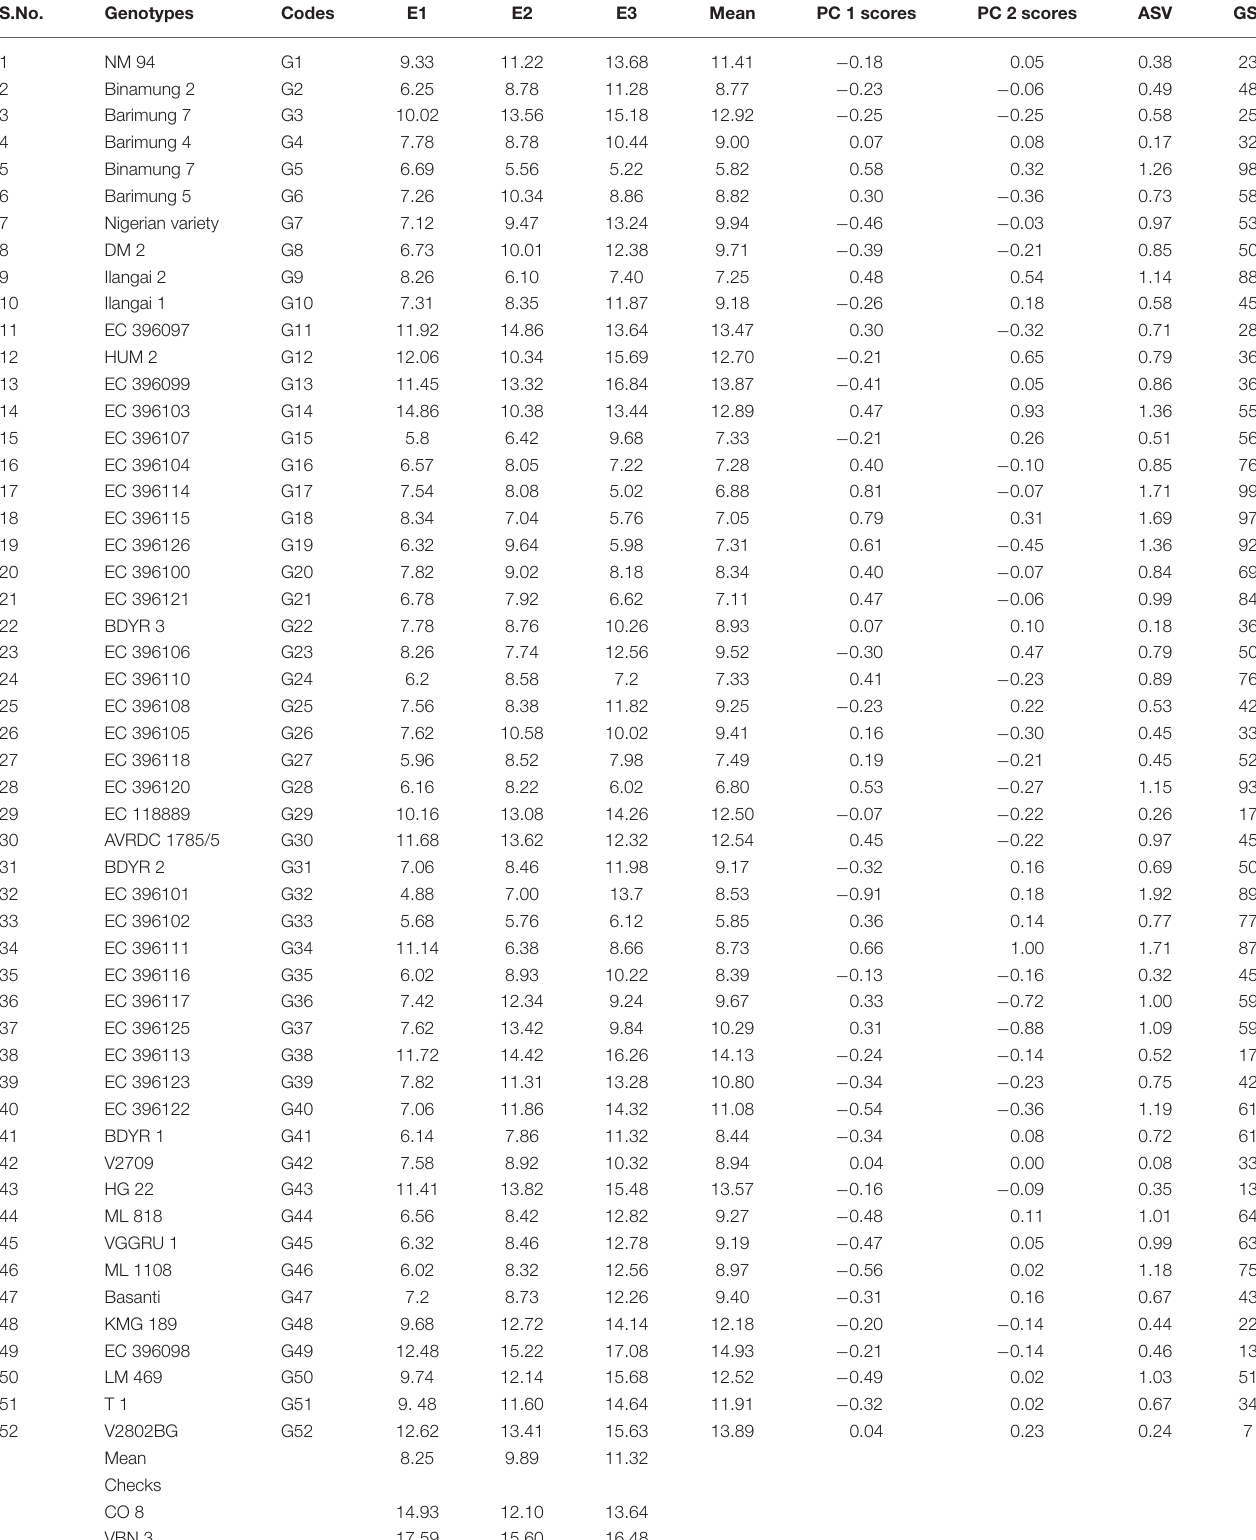
TABLE 5 | Mean grain yield, AMMI stability value (ASV) and genotype selection index (GSI) of mungbean accessions.